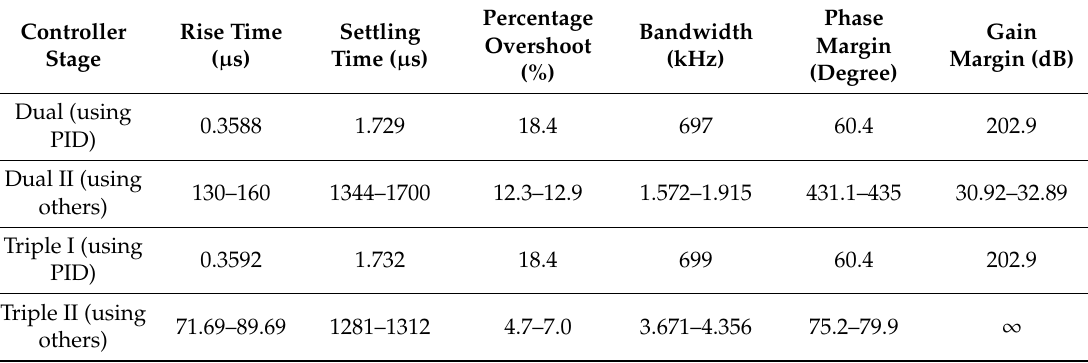
Table 4. Summary of results.